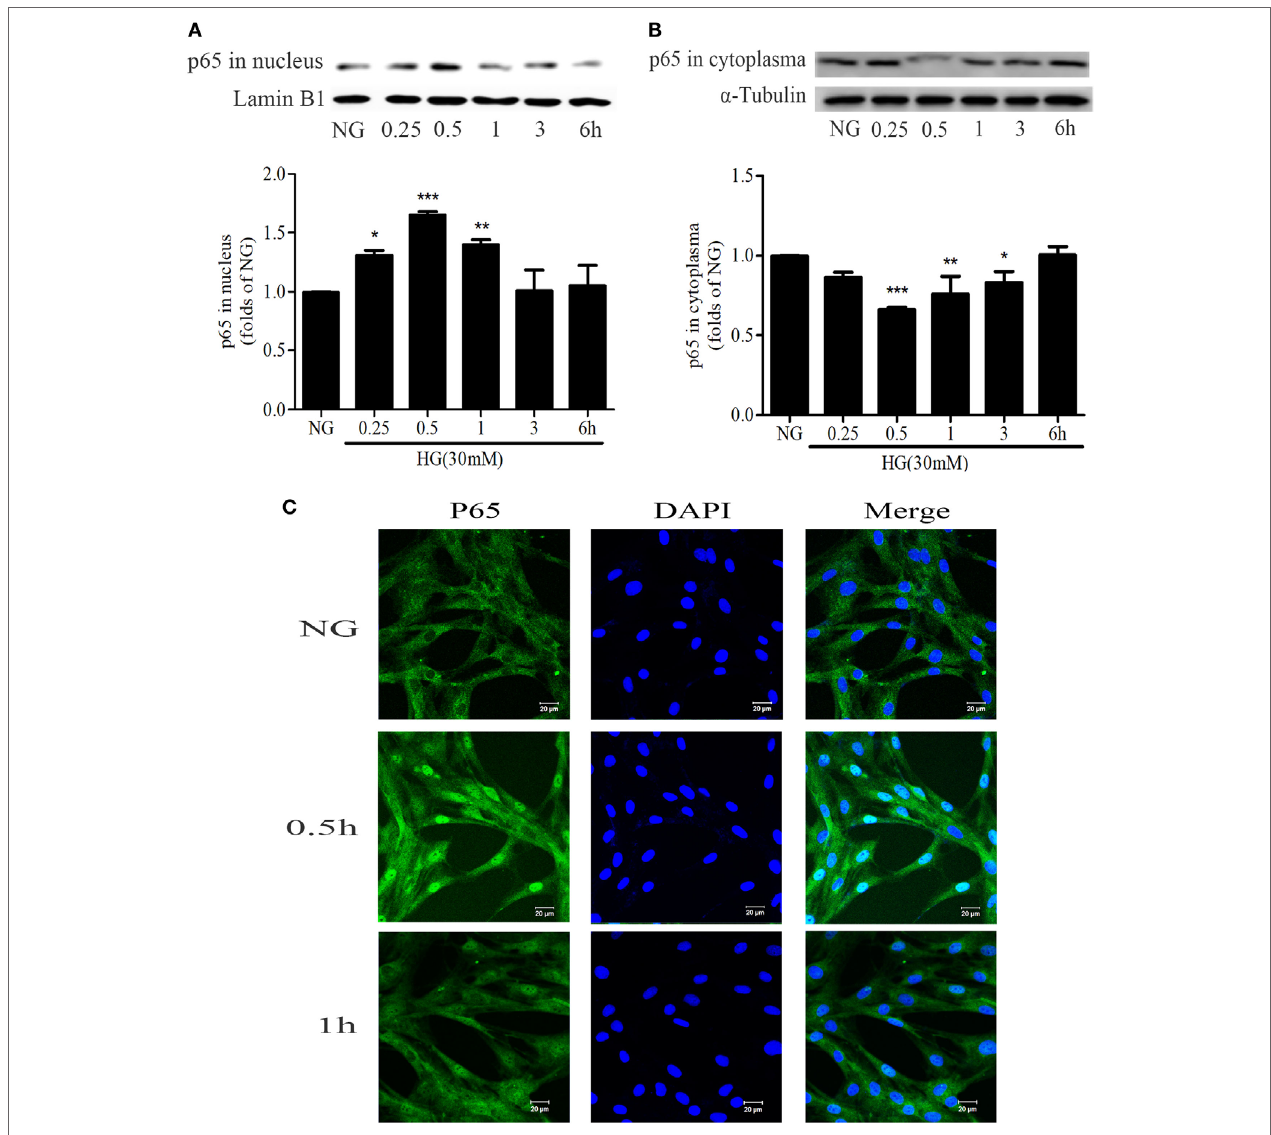
FigUre 4 | High glucose (HG) stimulation enhanced NF- κ B nuclear translocation in glomerular mesangial cells. HG-induced nuclear accumulation of p65 reached a maximum level at 0.5 h, and then decreased at 1 h (a,B) . * P < 0.05, ** P < 0.01, *** P < 0.001 vs. NG. Immunofluorescent staining showed the subcellular distribution of p65 in nuclei and cytoplasm at the indicated time points (0, 0.5, and 1 h) under HG conditions (c) . Blue and green stains indicate nuclei and p65, respectively. Bar: 20 µm. Independent experiments were performed at least three times with similar